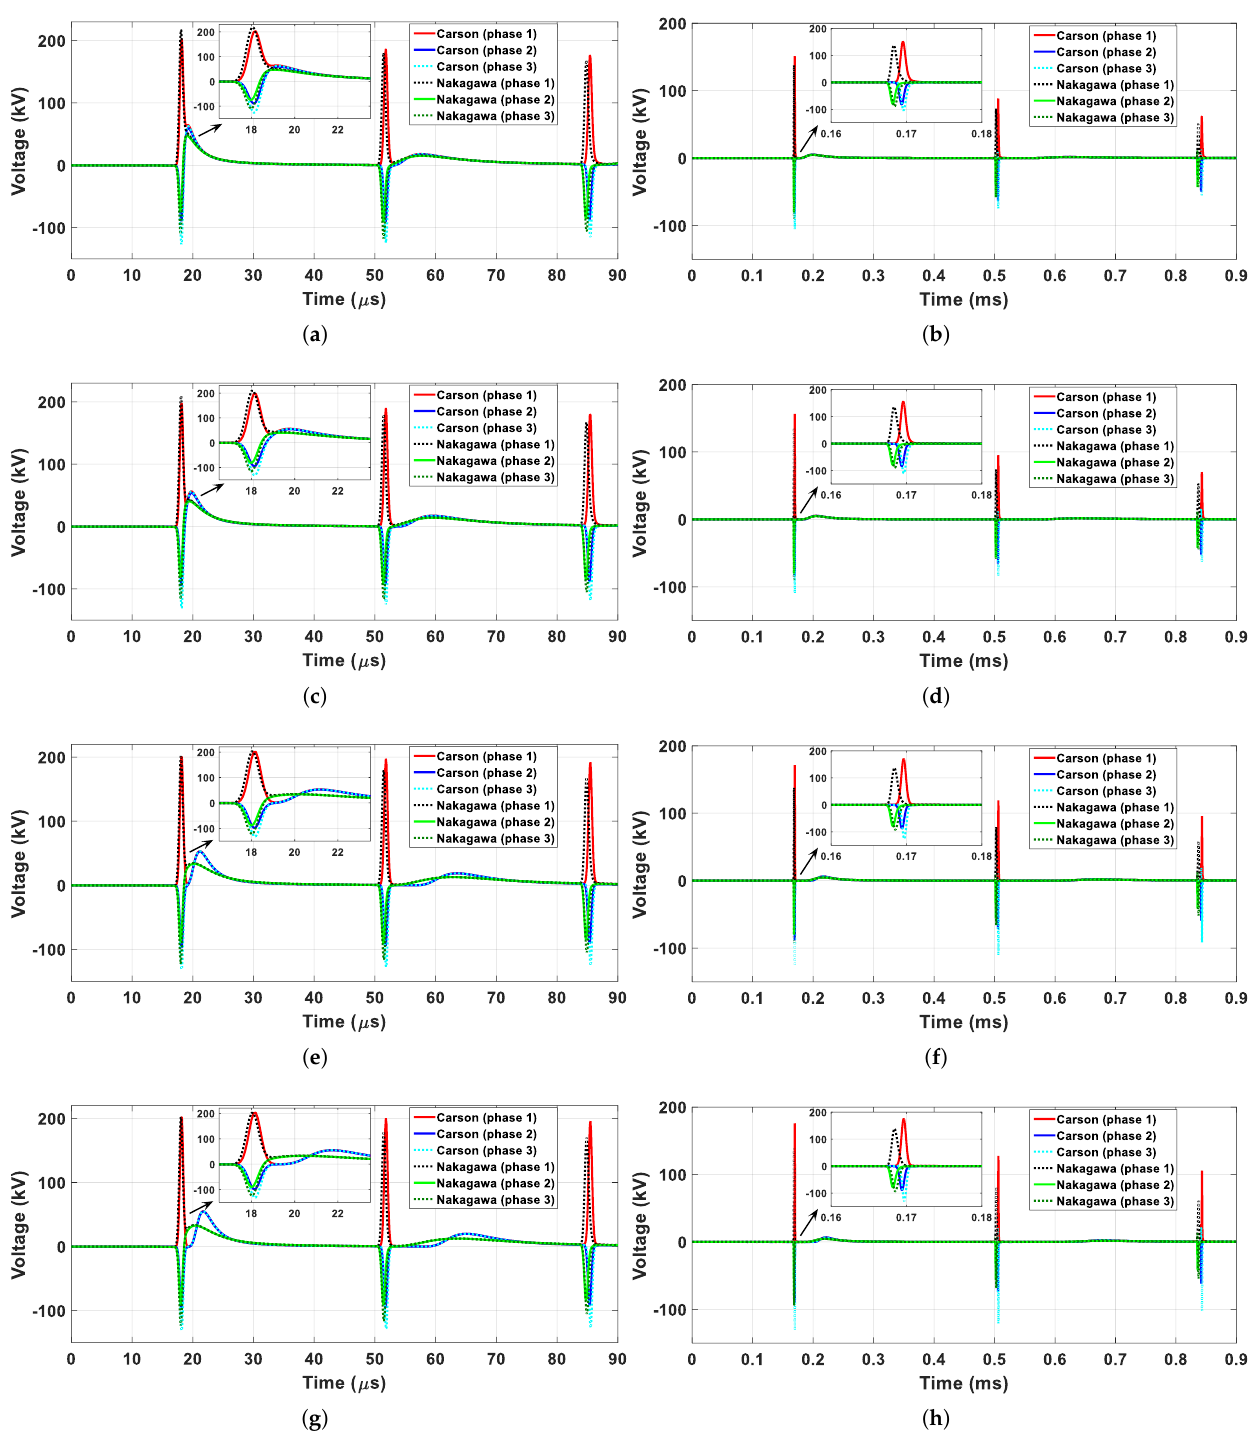
Figure 14. Transient voltages at the receiving end of the TL of Figure 12 when the current source is the 1MHz- FWHM gaussian pulse of Section 4.2, and the length of the line and soil resistivity are, respectively, ( a ) 5 km–500 Ω ·